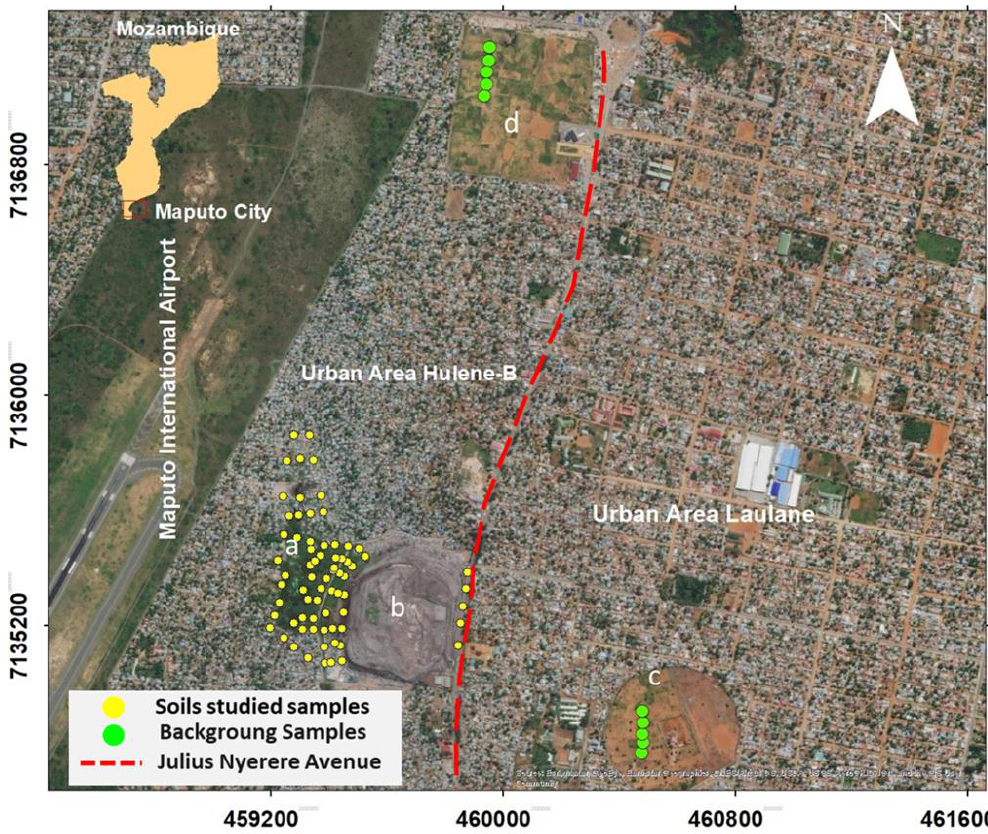
Figure 1. Study area with ( a ) dune depression, ( b ) Hulene-B waste dump, and ( c , d ) areas considered not impacted.